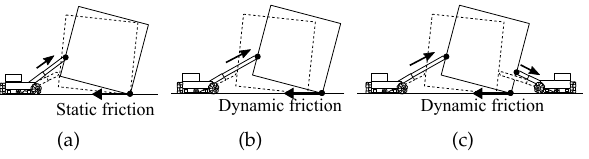
Figure 2. Frictional constraint on object’s motion in fixed and sliding cases: ( a ) A robot tilts an object with fixed contact on the floor; ( b ) a robot tilts an object with sliding contact; ( c ) two robots tilts an object with sliding